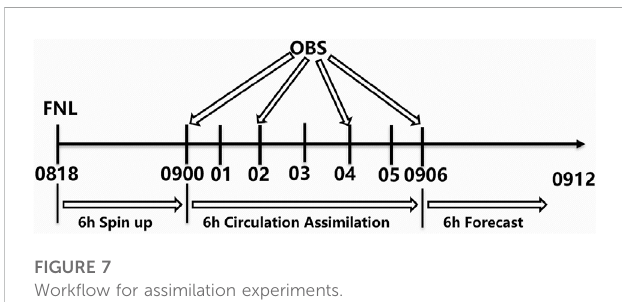
FIGURE 7 Work fl ow for assimilation